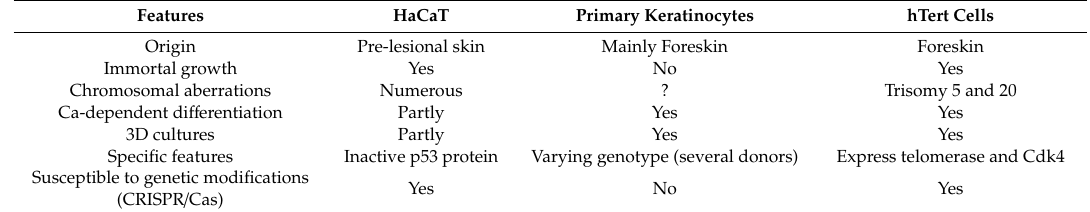
Table 1. Comparison of the three most common cell models used for studies in